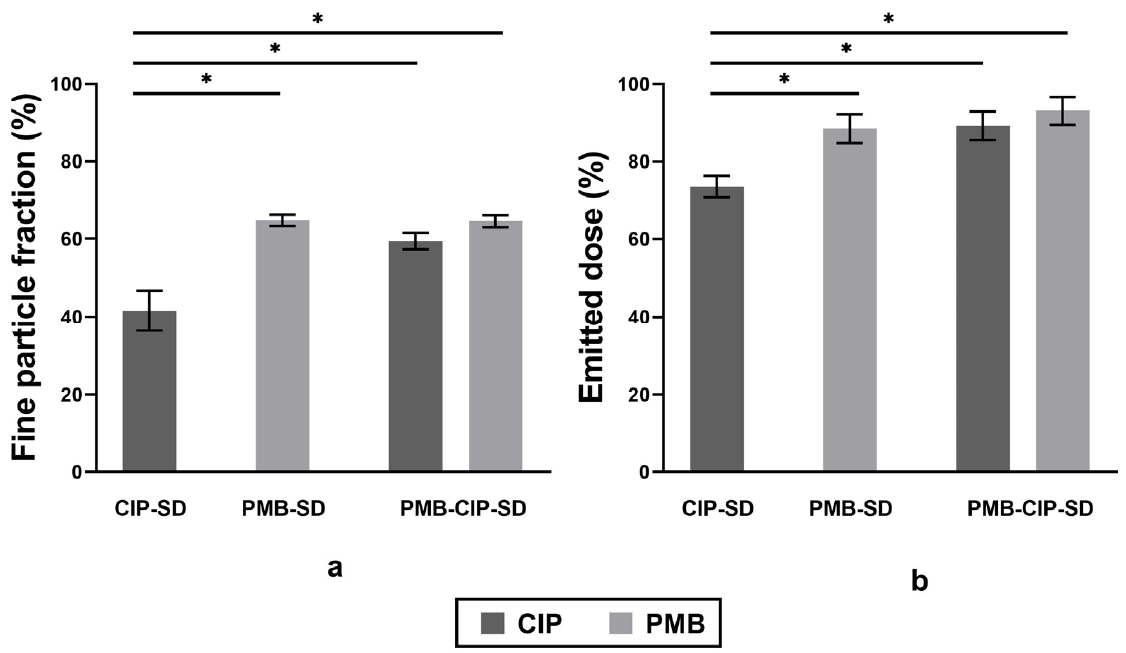
Figure 6. Fine particle fractions (FPF) ( a ) and emitted dose (ED) ( b ) of spray − dried formulations (mean ± SD, n = 3). Significant differences ( p < 0.05) are indicated with asterisk.